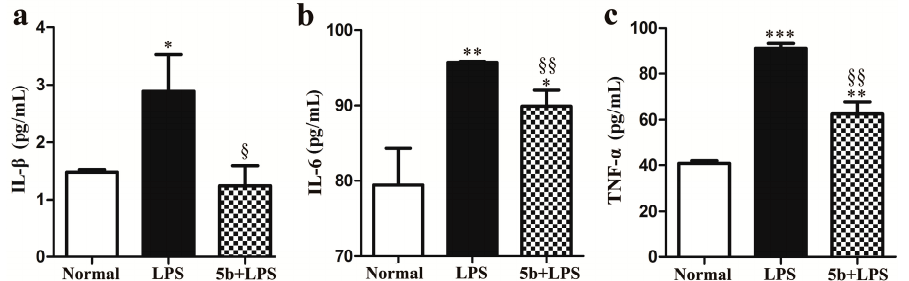
Figure 6. Effect of 5b on IL-1 β ( a ); IL-6 ( b ); and TNF- α ( c ) release induced by LPS in HK-2 cells.